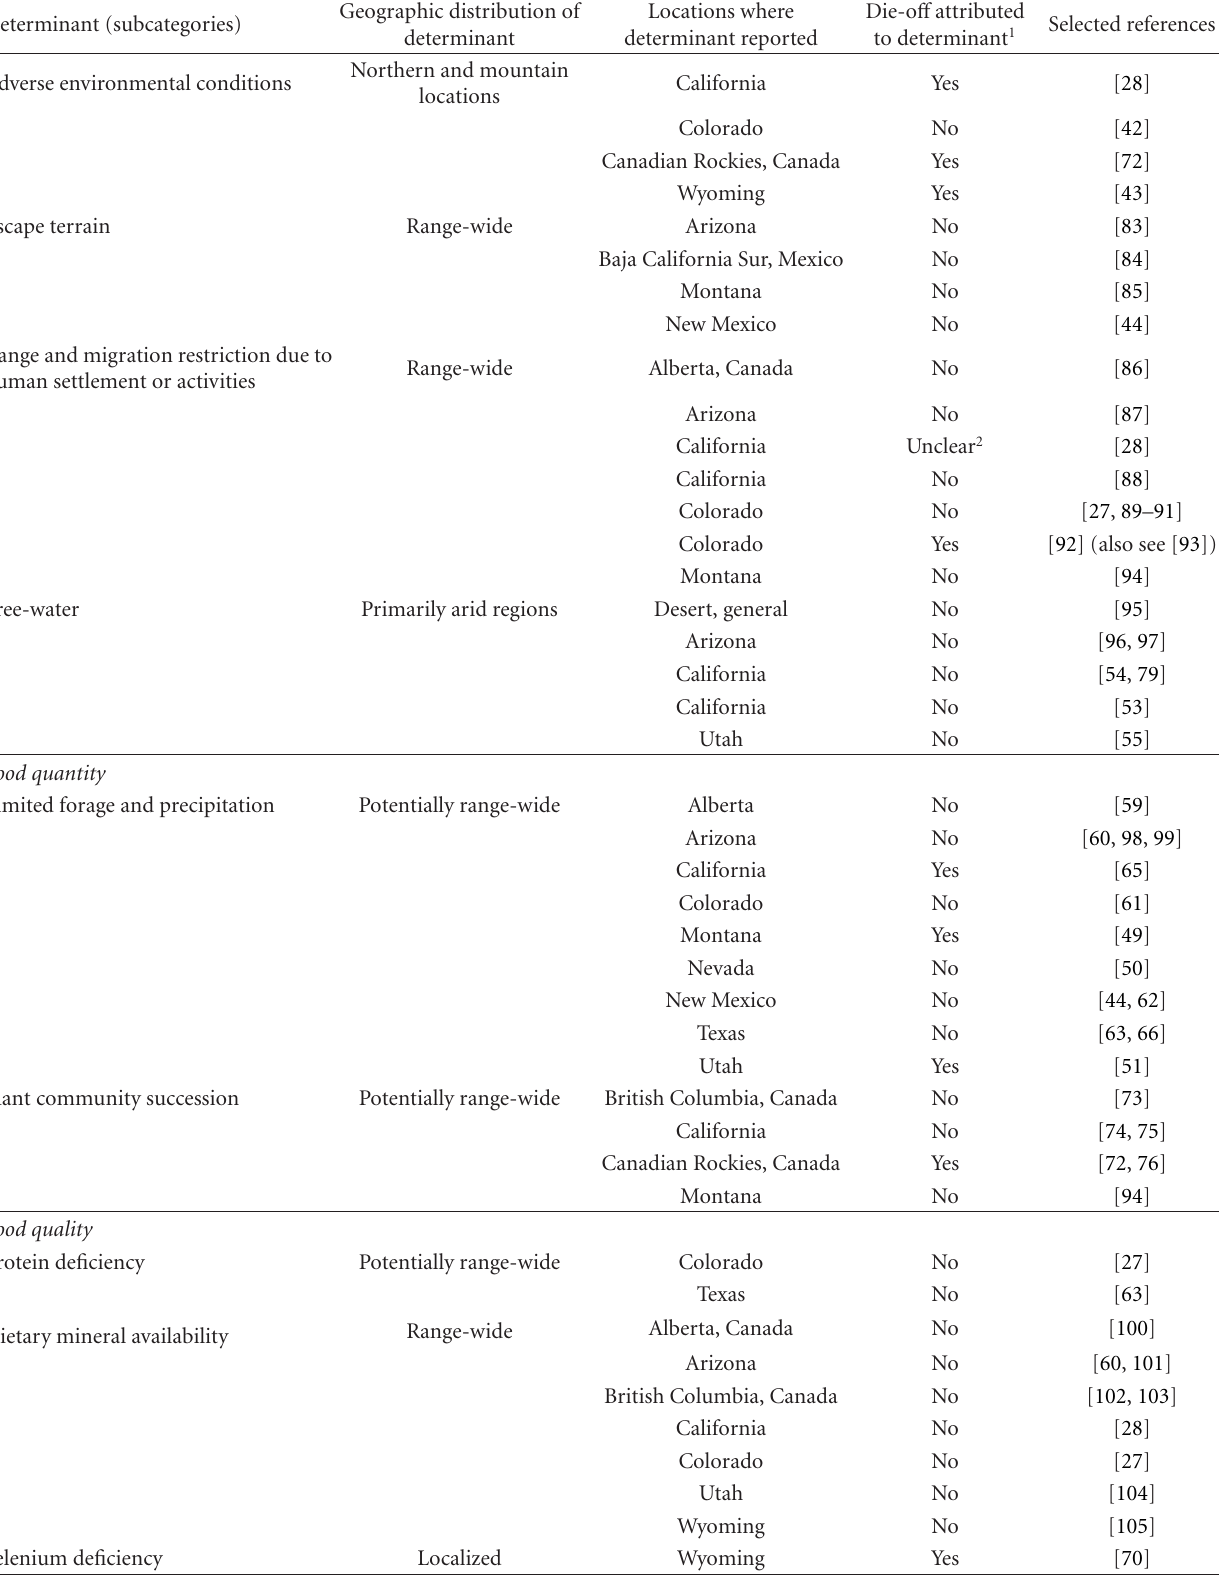
Table 2: Environmental determinants proposed to limit free-ranging bighorn sheep